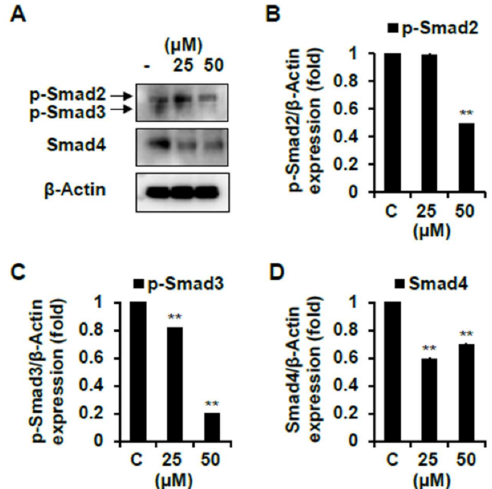
Figure 9. Skeletal muscle cell differentiation activity of compound 1 on C2C12 differentiated cells. The levels of p-Smad2/3 and Smad4 proteins were determined using a Western blot analysis. Every level of proteins versus β -Actin were measured by densitometry. C, control. Experiments were performed in triplicate and the data were expressed as mean ± SE; ** p < 0.01 as compared to the control (untreated cells